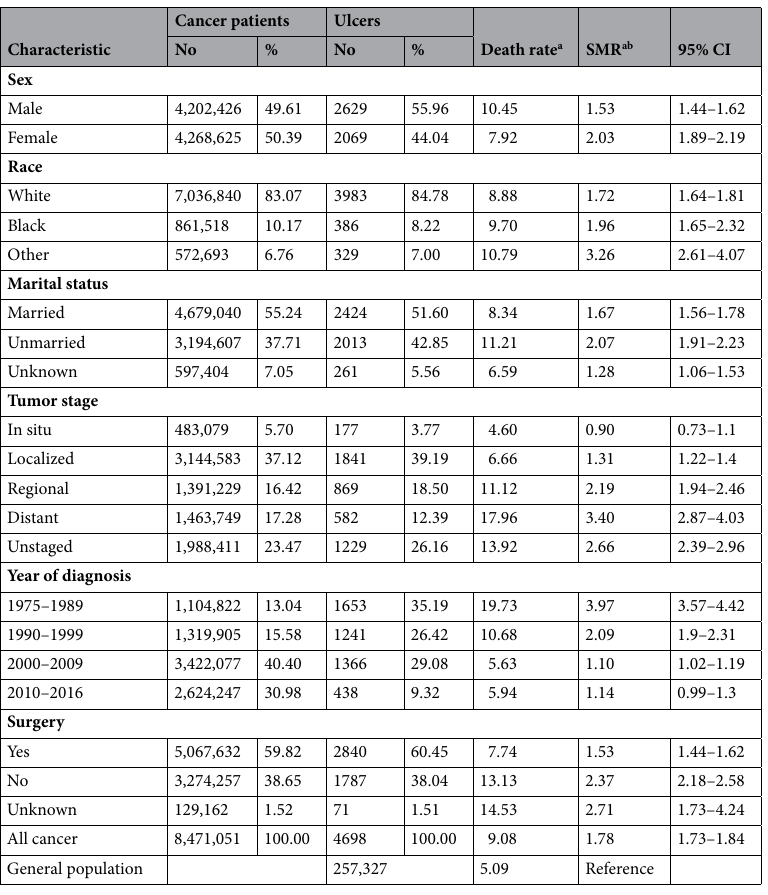
Table 1. Incidence and SMRs of gastroduodenal ulcer mortality among cancer patients. a Adjusted for age distribution of the cancer population in the SEER program. b For the categories of sex and race, the reference population for SMR was the specific category in the subpopulation of general US people (e.g., the SMR for males is the observed number of deaths in men with cancer divided by the expected number of deaths based on the rate of men in the general population). For marital status, stage at presentation, surgery, chemotherapy, radiotherapy, and year of diagnosis, the reference population for SMR was the entire general US population from 1975 to